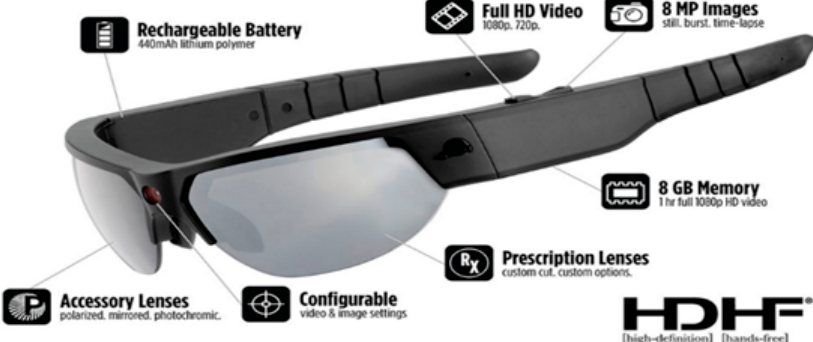
Figure 1. The Pivothead sunglasses used in this study.